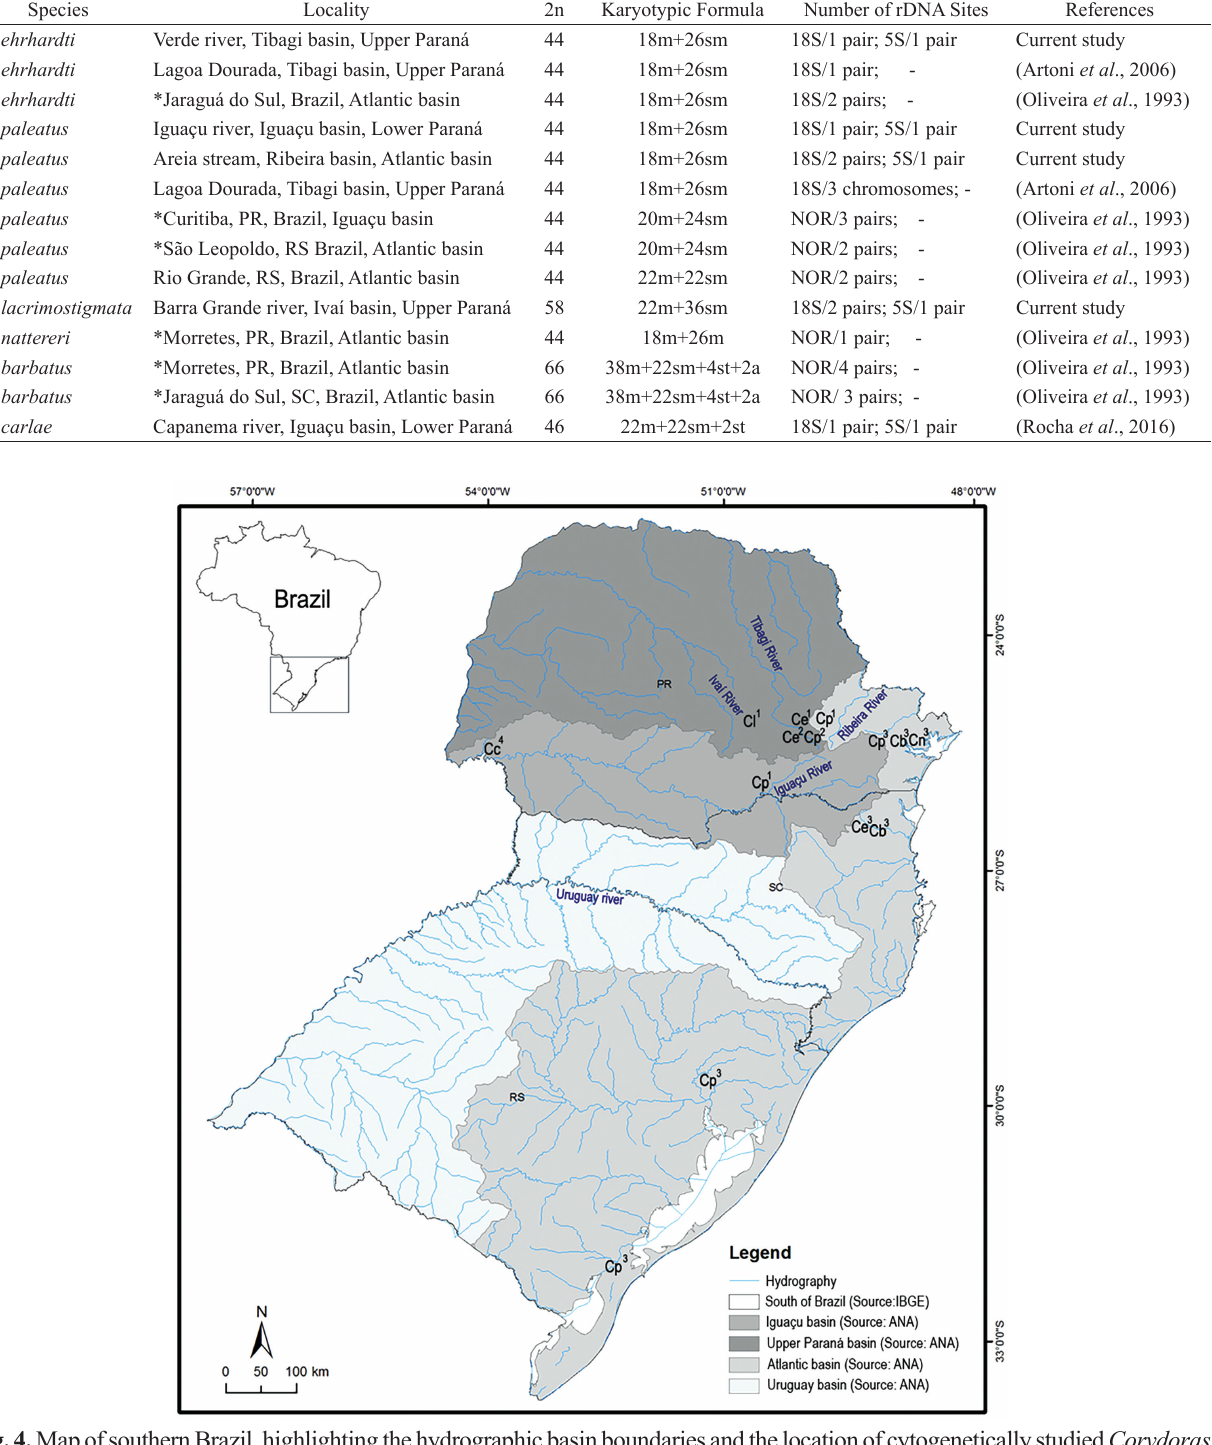
Fig. 4. Map of southern Brazil, highlighting the hydrographic basin boundaries and the location of cytogenetically studied Corydoras species. PR = Paraná State; SC = Santa Catarina State; RS = Rio Grande do Sul State; Cb = S. barbatus ; CC = C. carlae ; Ce = C. ehrhardti ; Cl = C. lacrimostigmata ; Cn = C. nattereri ; Cp = C. aff. paleatus ; 1 = Present study; 2 = Artoni et al . (2006); 3 = Oliveira et al . (1993); 4 Rocha et al . (2016); ANA= Agência Nacional das Águas and; IBGE = Instituto Brasileiro de Geografia e